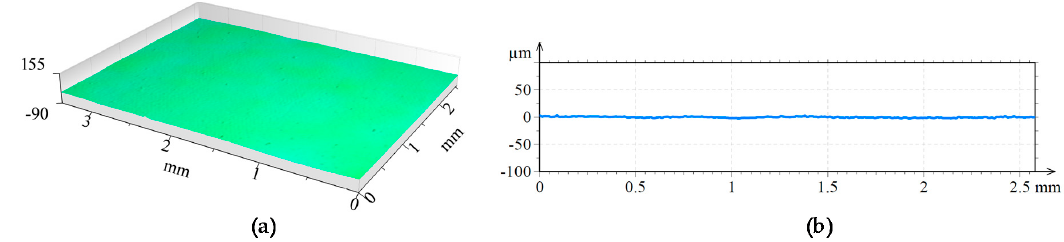
Figure 11. ( a ) Topography and ( b ) surface profile LMD + LBM + LP.